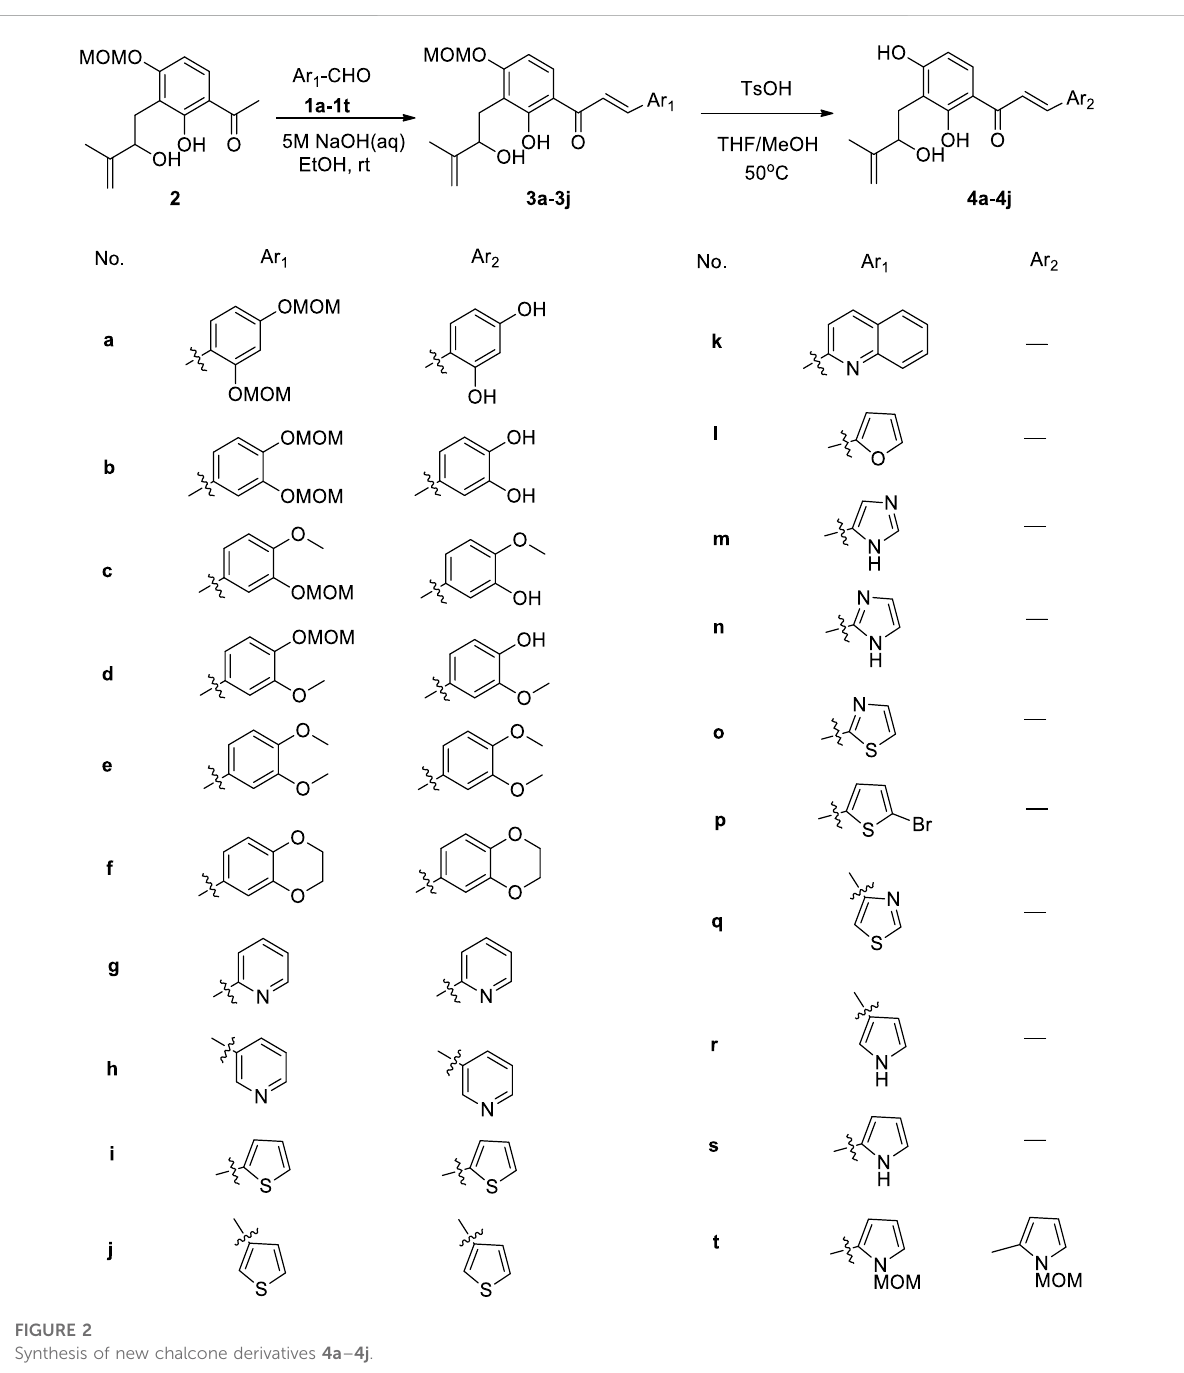
(Figure 4C). In contrast, in the presence of sanjuanolide, the E . coli CMCC 44102 cells showed slight changes (Figure 4D). These results suggest that sanjuanolide may cause severe cellular structure damage to S. aureus , which results in cell death. The SEM analyses were consistent with the results of the antibacterial tests.